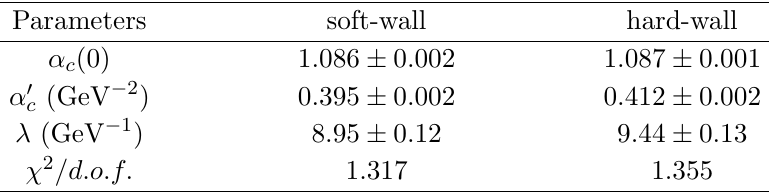
Table 1 . The (cid:12)tting results obtained with the di(cid:11)erential cross section data in the range, 546 GeV (cid:20) p s (cid:20) 13 TeV, and the total cross section data.